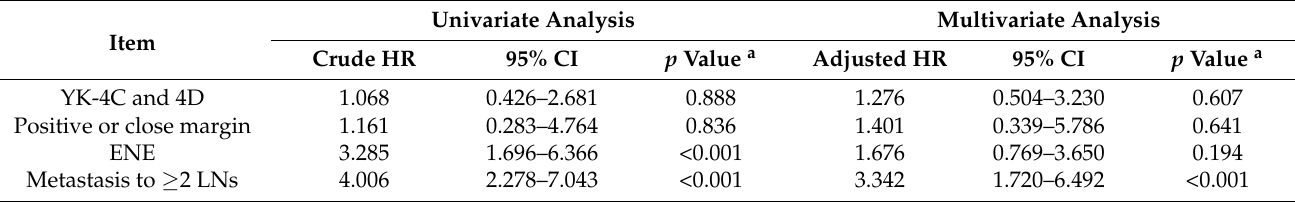
Table 2. Mortality of patients with OSCC with major risk factors after surgical treatment ( n =